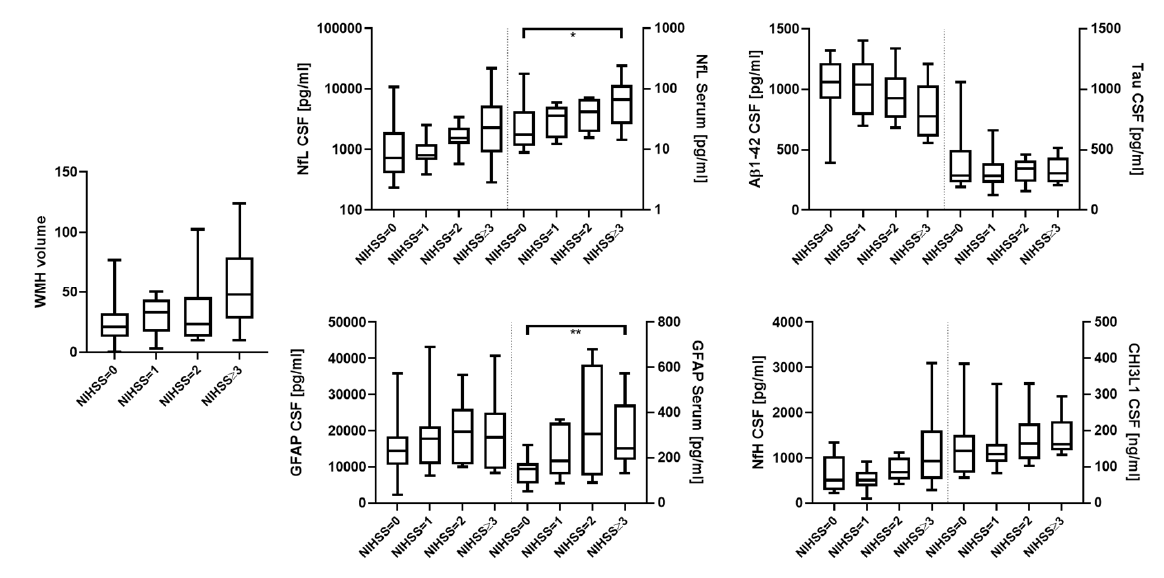
Figure 3. mRS (0, 1, 2 and ≥ 3) compared to WMH, NfL (CSF and serum), GFAP (CSF and serum),